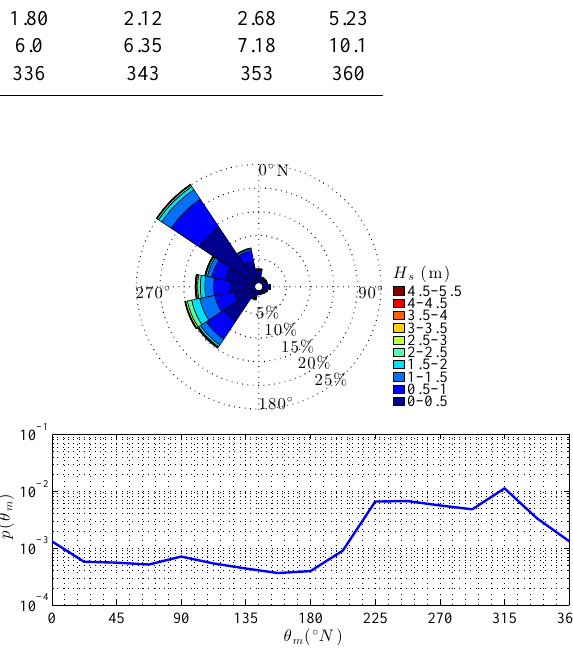
Figure 2. Observed bivariate wave climate at Acqua Alta: his- tograms representing the joint PDF of H s and θ m (top panel) and the marginal PDF of θ m (bottom panel). Resolutions are (cid:49)H s = 0 . 5m and (cid:49)θ m = 22 . 5 ◦